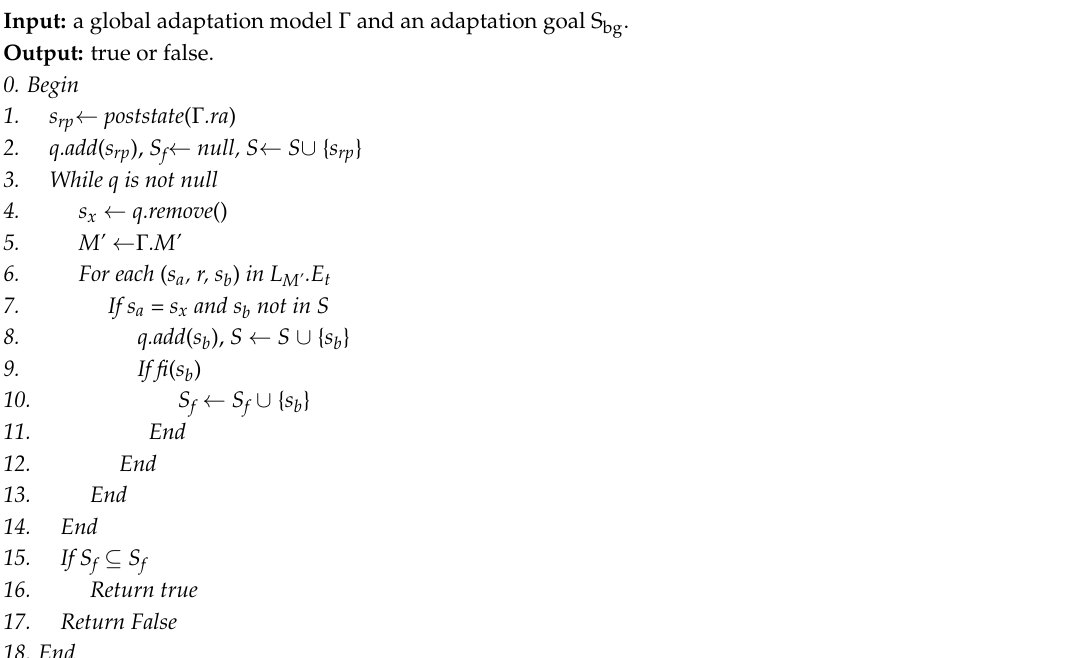
Algorithm 1. Correctness checking